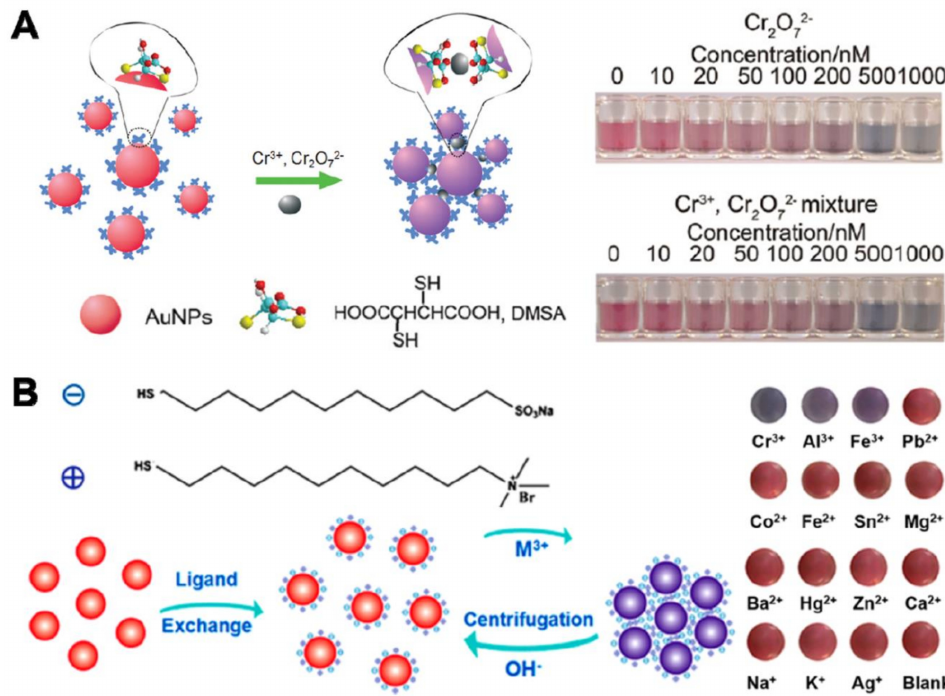
Figure 35. Sulfhydryl compound-modified Au NPs visual biosensors for heavy metal ion detection. ( A ) DMSA- functionalized Au NPs for both the Cr(III) and Cr(VI) fast detection. ( B ) To adjust the Au NPs to produce inter-molecular zwitterionic (Zw) surfaces, mixed charge thiols are employed. The M 3+ can efficiently cause aggregation of the Zw-Au NPs by interfere with their surface-potential, like Fe 3+, Al 3+ and Cr 3+ and the aggregated Au NPs could be re-generated and re-cycled via removing M 3+ + . Adapted with permission from reference [223], Copyright 2016,